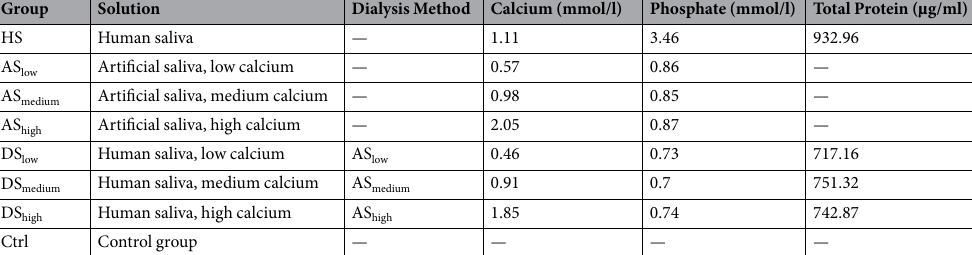
Table 1): humid chamber (control, Ctrl group); human whole stimulated centrifuged saliva (HS group); three artificial saliva (AS) groups (AS low , AS medium , and AS high ); and three groups of dialysed HS (DS), which were pre- pared by dialysing HS with the different AS groups (DS low , DS medium , and DS high ) (Table 1). The 3 types of artificial saliva (AS) had the same general composition (0.9 mM KH 2 PO 4, 130 mM KCl, 60 mM Tris, pH 7.4) except for their calcium concentrations: AS low contained 0.5 mM Ca(NO 3 ) 2 , AS medium 1.0 mM Ca(NO